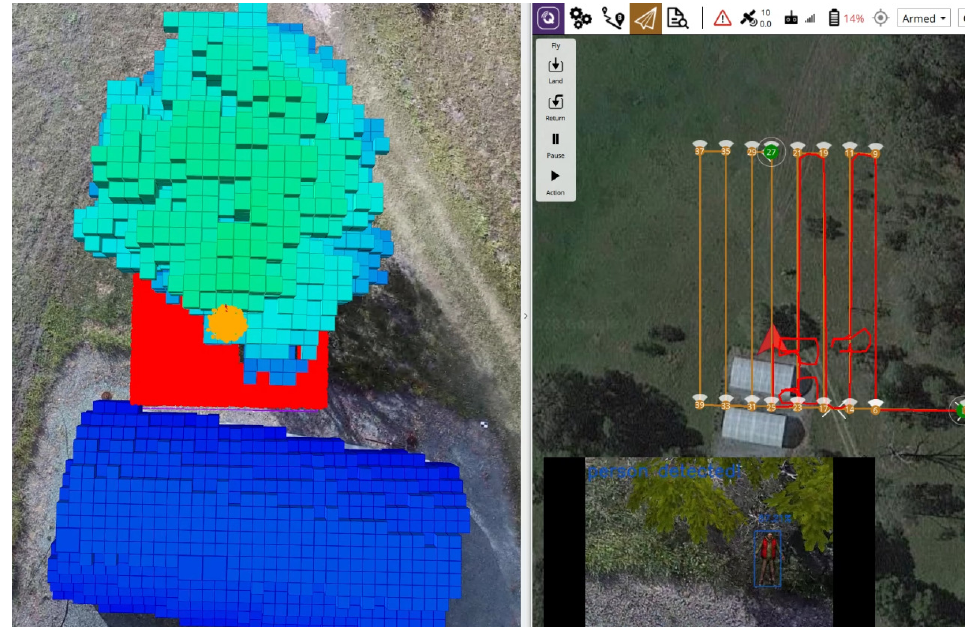
Figure 12. Probabilistic distribution of initial UAV and victim position belief under hybrid flight mode. The UAV position belief (orange points) follows a normal distribution, with a mean equals to the current UAV position where a potential victim is first detected, and standard deviation of 1.5 m. The victim position belief (red points) follow a uniform distribution whose limits are equivalent to the extent of the camera’s